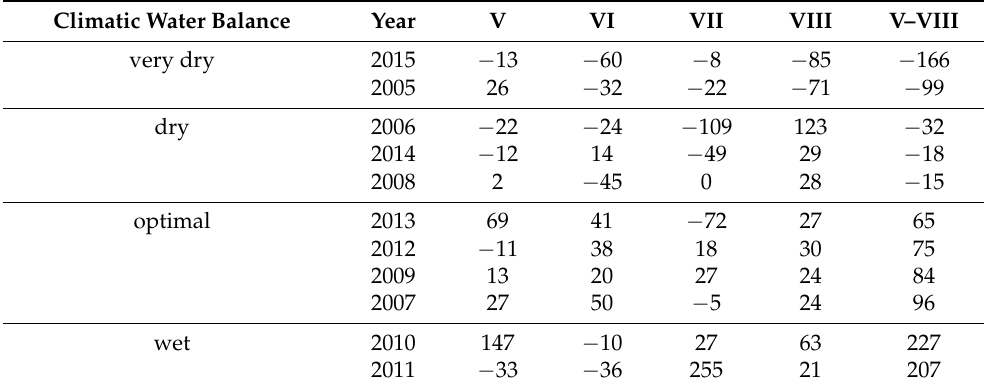
Table 2. Classification of the precipitation condition with the climatic water balance (mm) of the potato growing season in Jadwisin for months (columns: V, VI, VII, and VIII and summary: V–VIII) in particular years of 2005–2015.